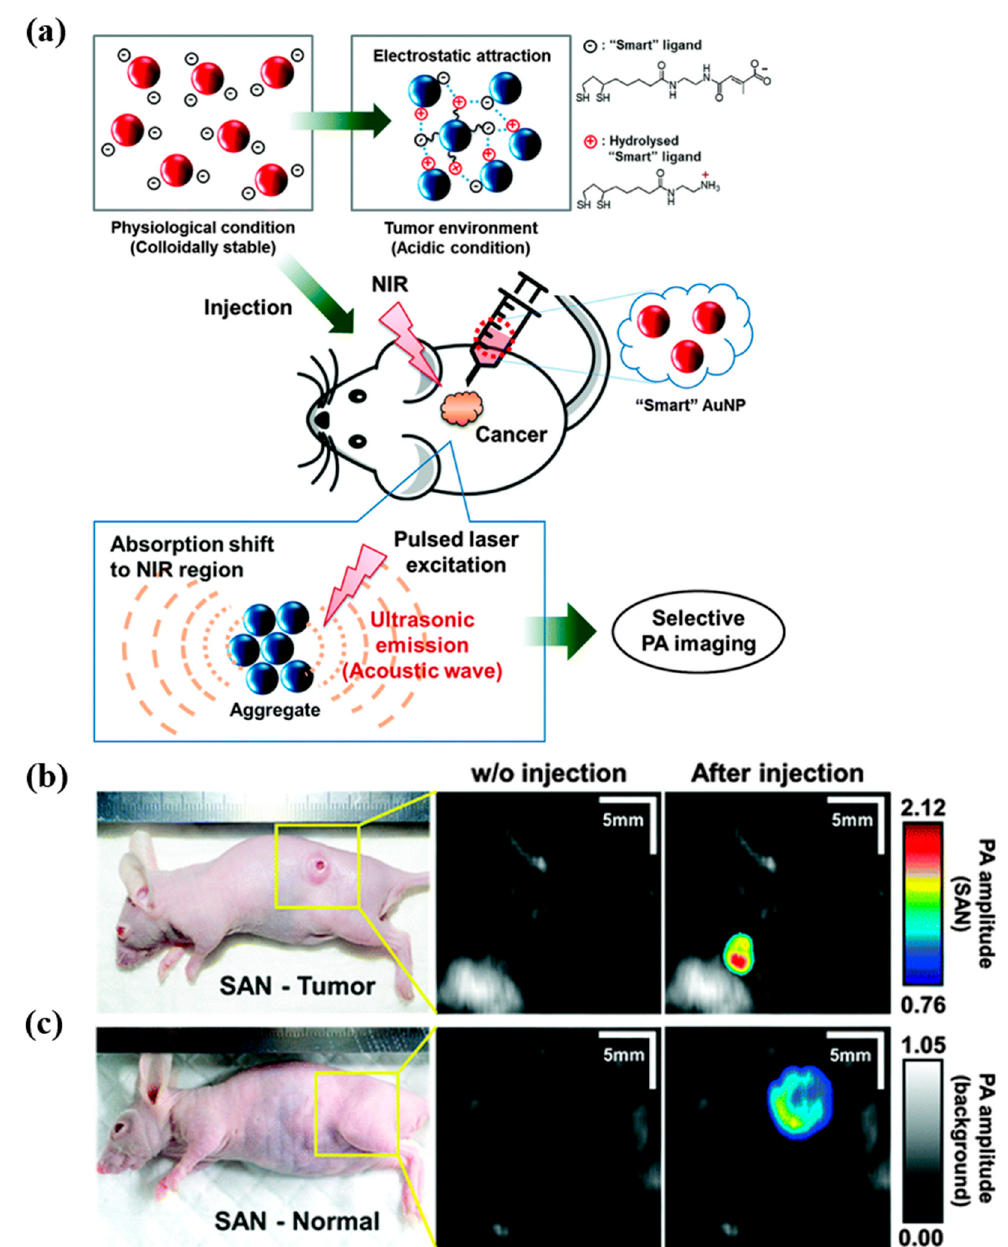
Figure 3. ( a ) Schematic illustration of the working mechanism of “smart” gold nanoparticles (SAN) for photo acoustic imaging (PAI). ( b ) Photograph (left) and PA MAP images (680-nm laser illumination) of tumor xenograft models before (center) and after (right) injecting SAN solution and ( c ) photograph (left) and PA MAP images of normal model before (center) and after (right) injecting SAN solution. Reprinted with permission from Reference [67]. Copyright 2016 Royal Society of Chemistry.